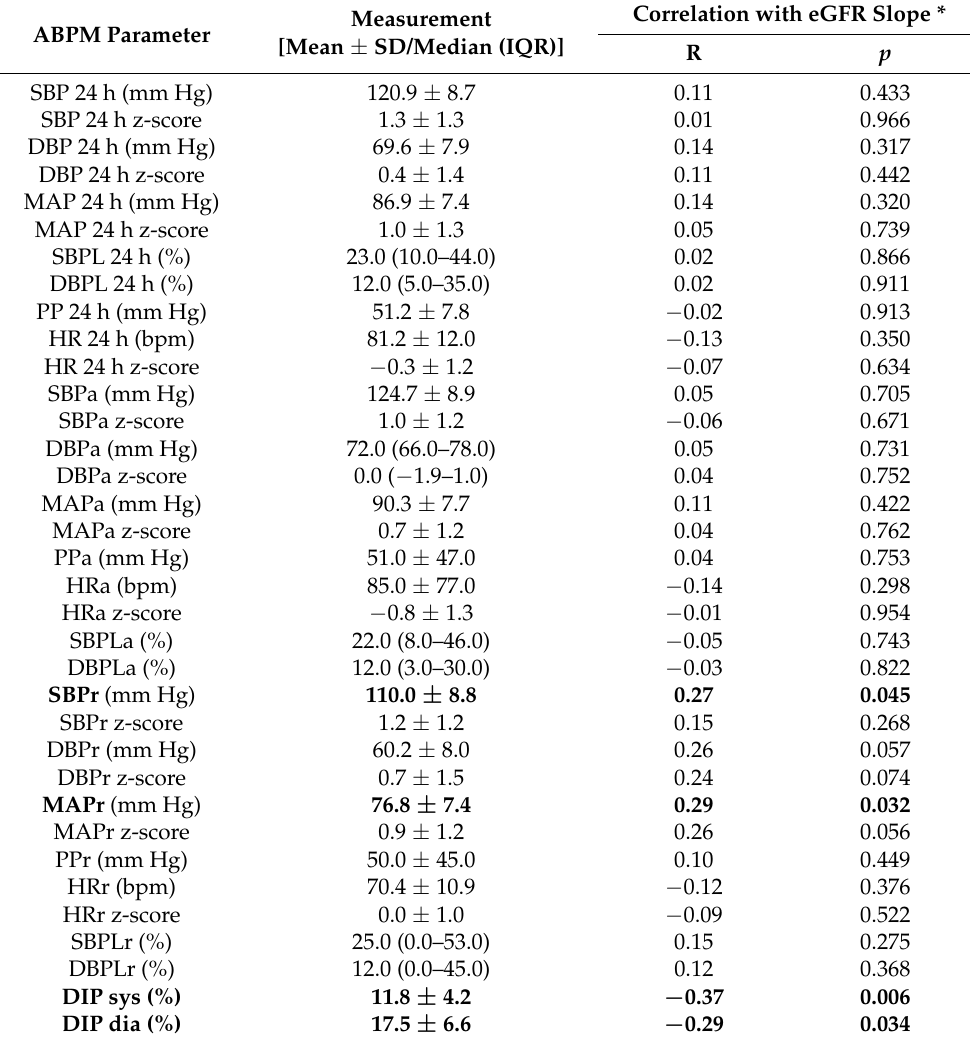
Table 3. Values of ABPM parameter measurements and their correlations with eGFR